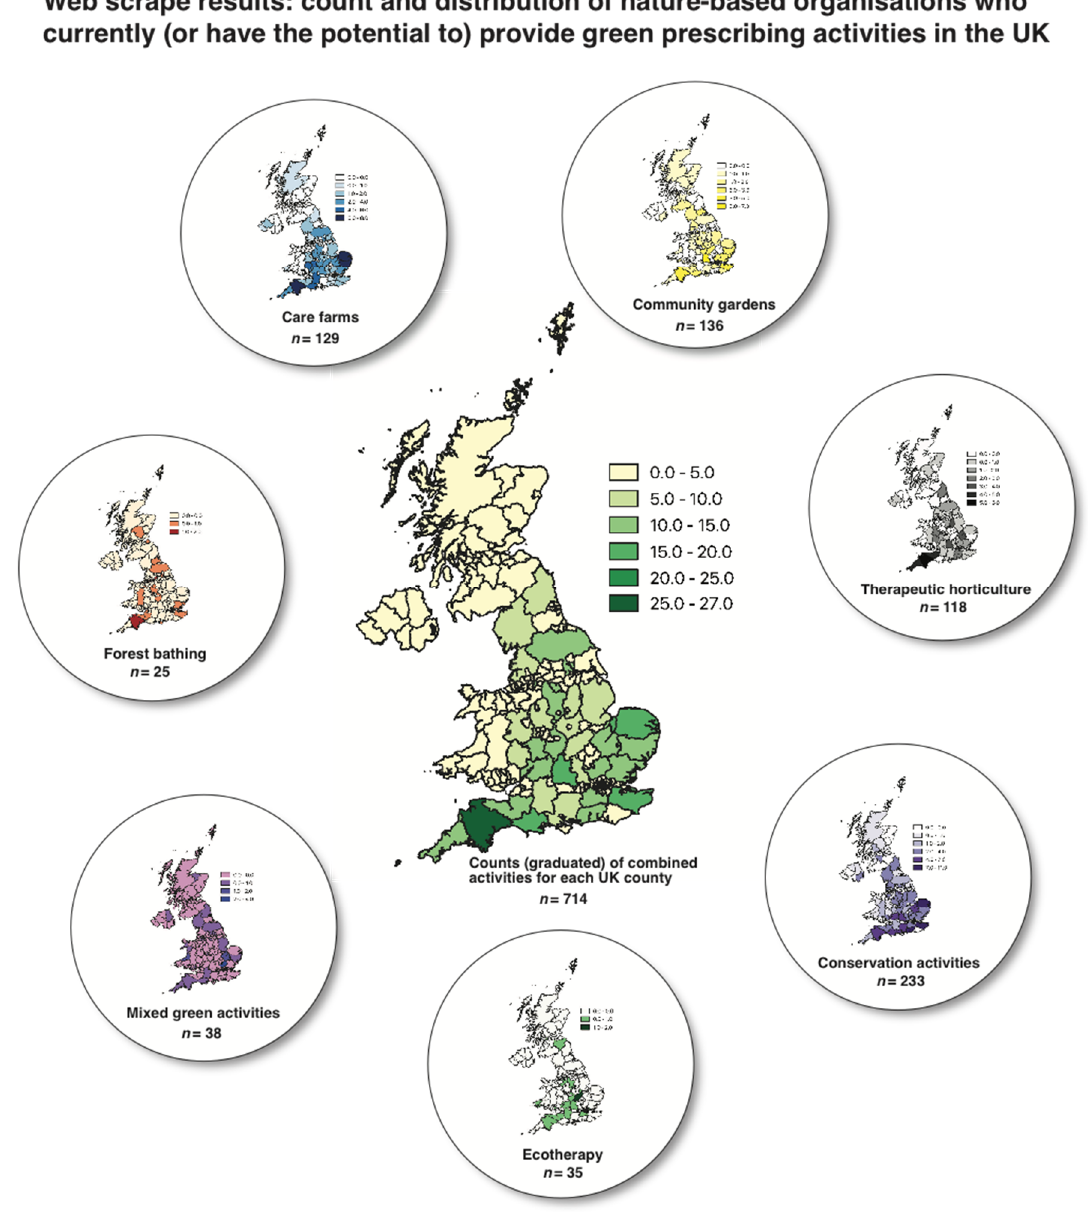
Figure 8. UK map of counties showing count ( n = 714) and distribution of nature-based organisations which currently (or have the potential to) provide green prescribing activities (inlets show counts/distribution for individual activities). The quantitative differences in values are presented using graduated symbology and an appropriate colour ramp. This was processed in QGIS.